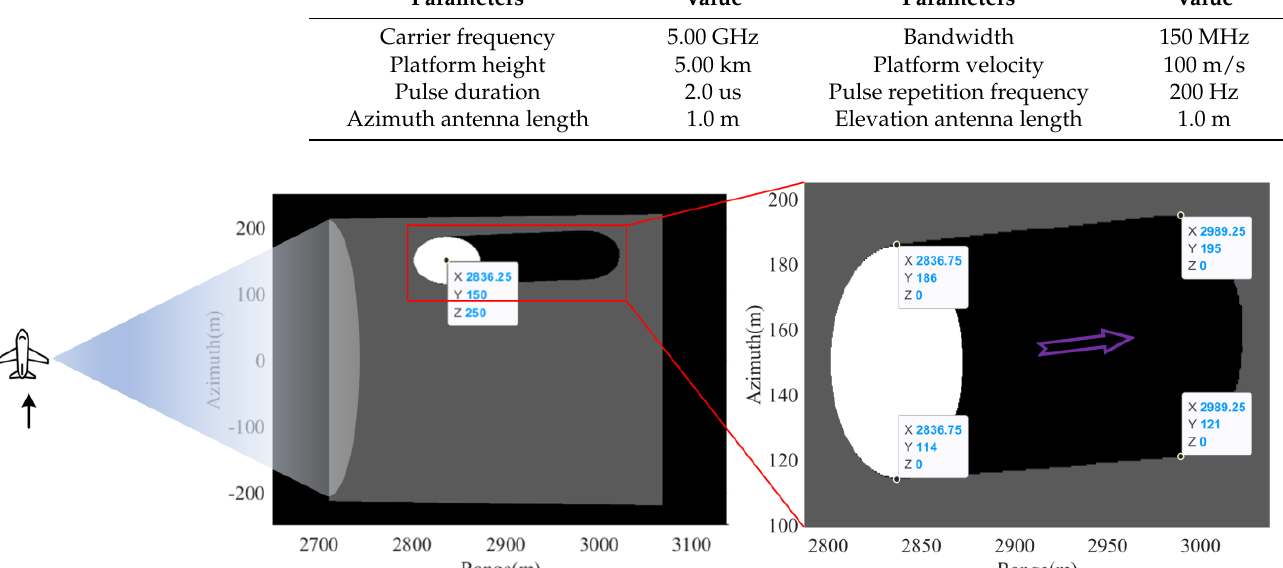
Figure 9. Occlusion judgment results of the proposed beam occlusion judgment.